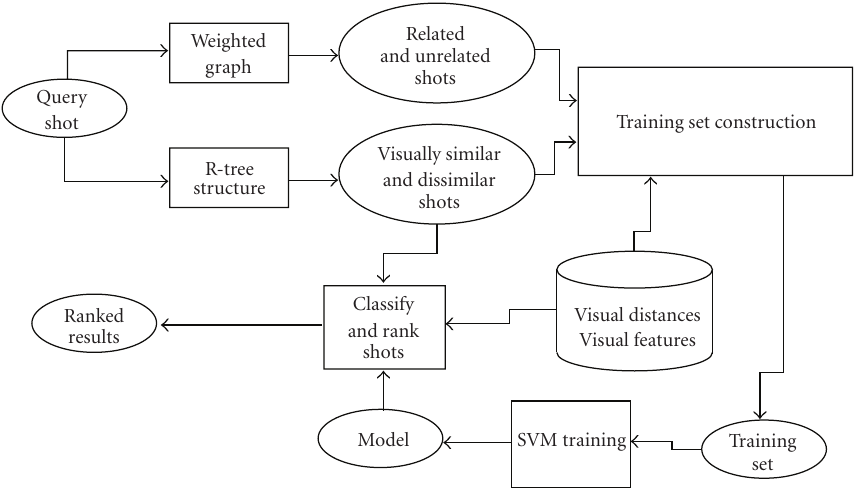
Figure 6: Algorithm to combine visual features and implicit user